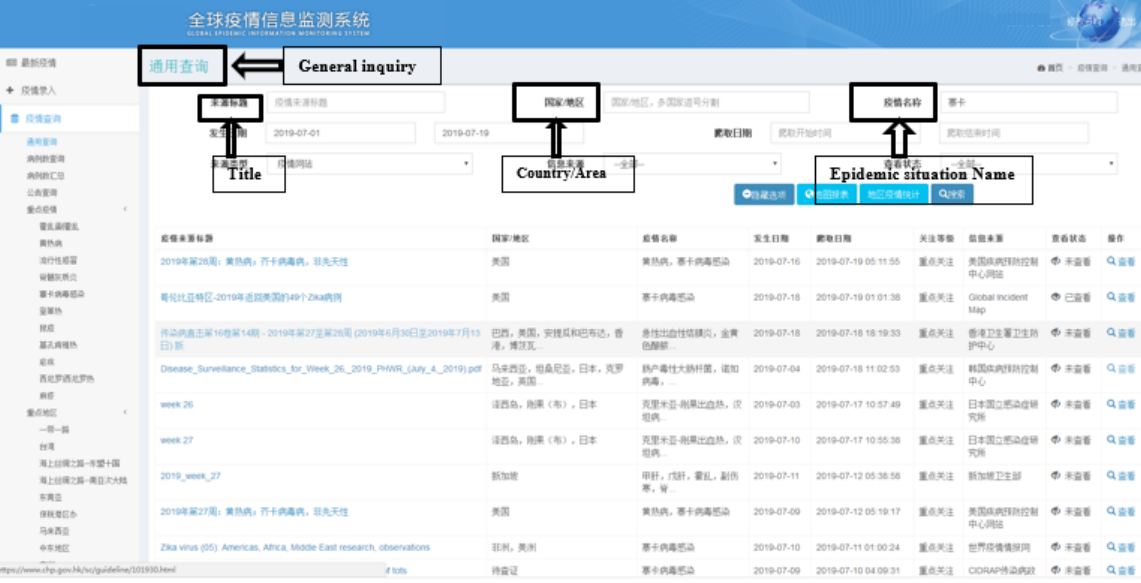
Figure 5. Sample inquiry about the Zika epidemic situation using the general inquiry function of the Global Infectious Diseases Epidemic Information Monitoring